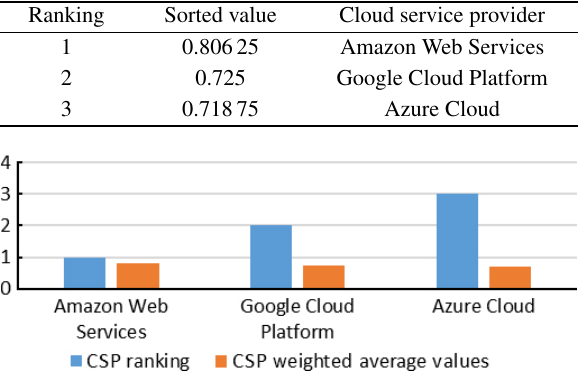
Fig. 7 Experiment 4